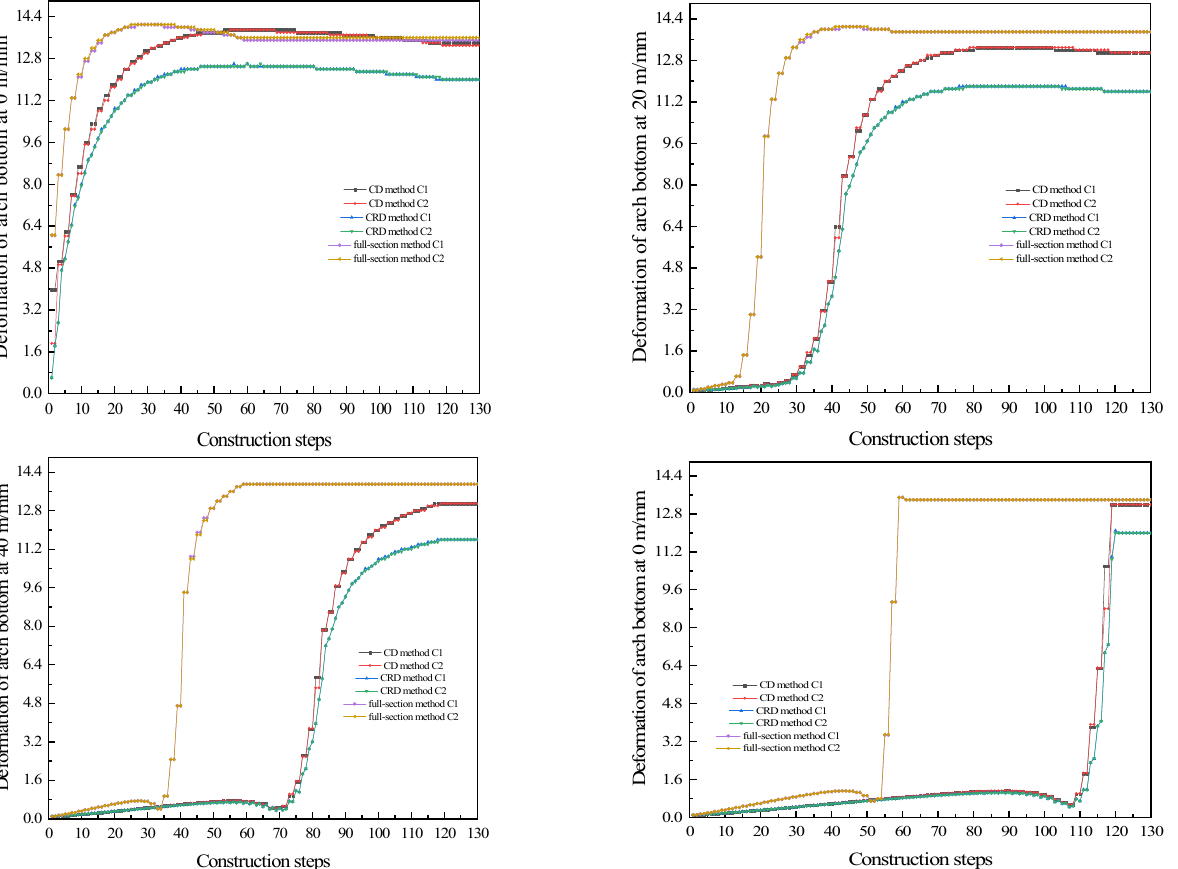
Figure 7. Deformation diagram of the arch bottom with different excavation methods.